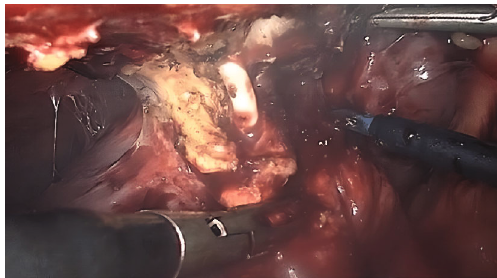
Figure 3: Percutaneous drainage catheter with fi stula